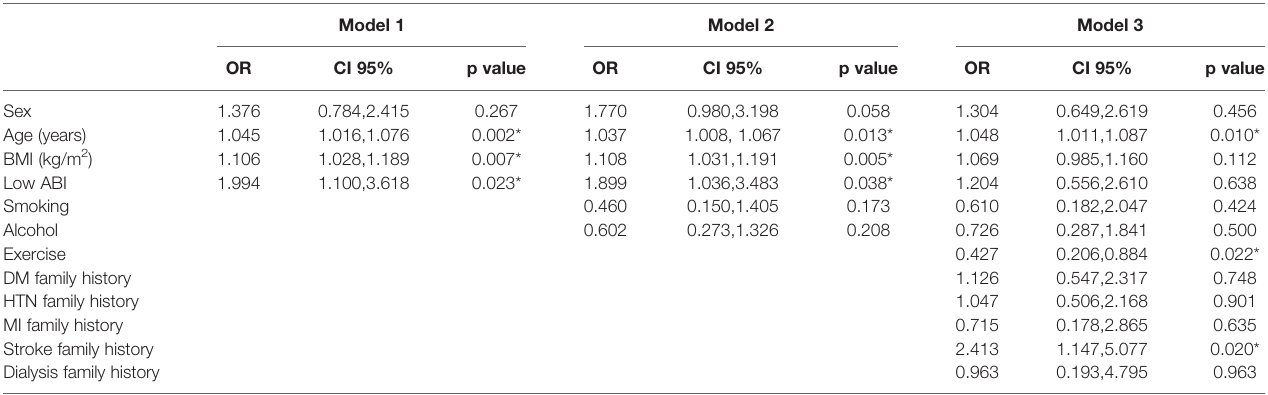
TABLE 3 | Odds ratios (OR) for stroke by logistic regression with multivariable